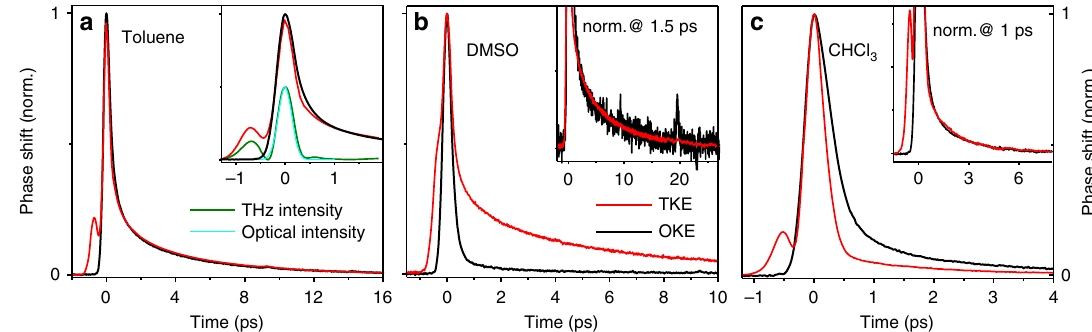
Figure 2 | Transient optical birefringence of liquids following THz and optical excitation. ( a ) TKE (red line) and OKE (black line) signals of toluene. Signals are normalized to the initial peak signal where the instantaneous electronic contribution is expected to dominate the birefringence signal. The inset shows the instantaneous intensity of the THz pump pulse ( E 2 ( t ), green line) and the optical pump pulse ( I ( t ), cyan line). ( b , c ) Same as a , but with data taken on DMSO ( b ) and chloroform ( c ), respectively. For DMSO, the maximum phase shift amounts to 6mrad at an incident peak THz field of 2MVcm (cid:2) 1 . The insets in b , c show the main-panel data but normalized to the signal amplitude at a delay of 1.5ps and 1ps,